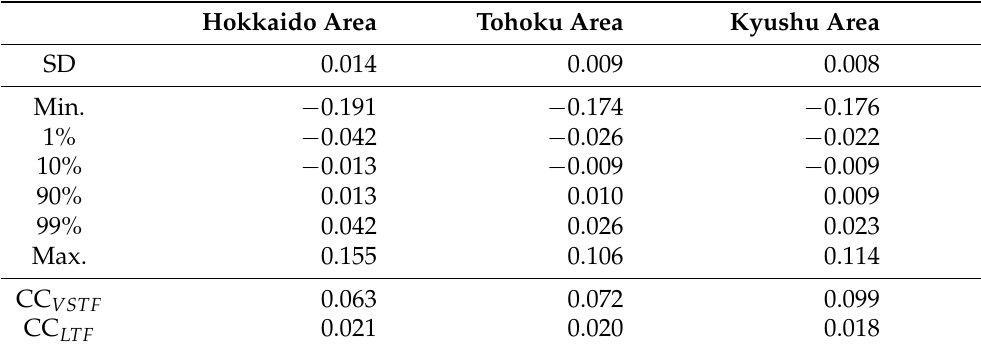
Table 2. Statistical properties of short-term fluctuations: standard deviation (SD) and correla- tion coefficients between short- and very short-term fluctuations (CC VSTF ) and long-term fluc- tuations (CC LTF